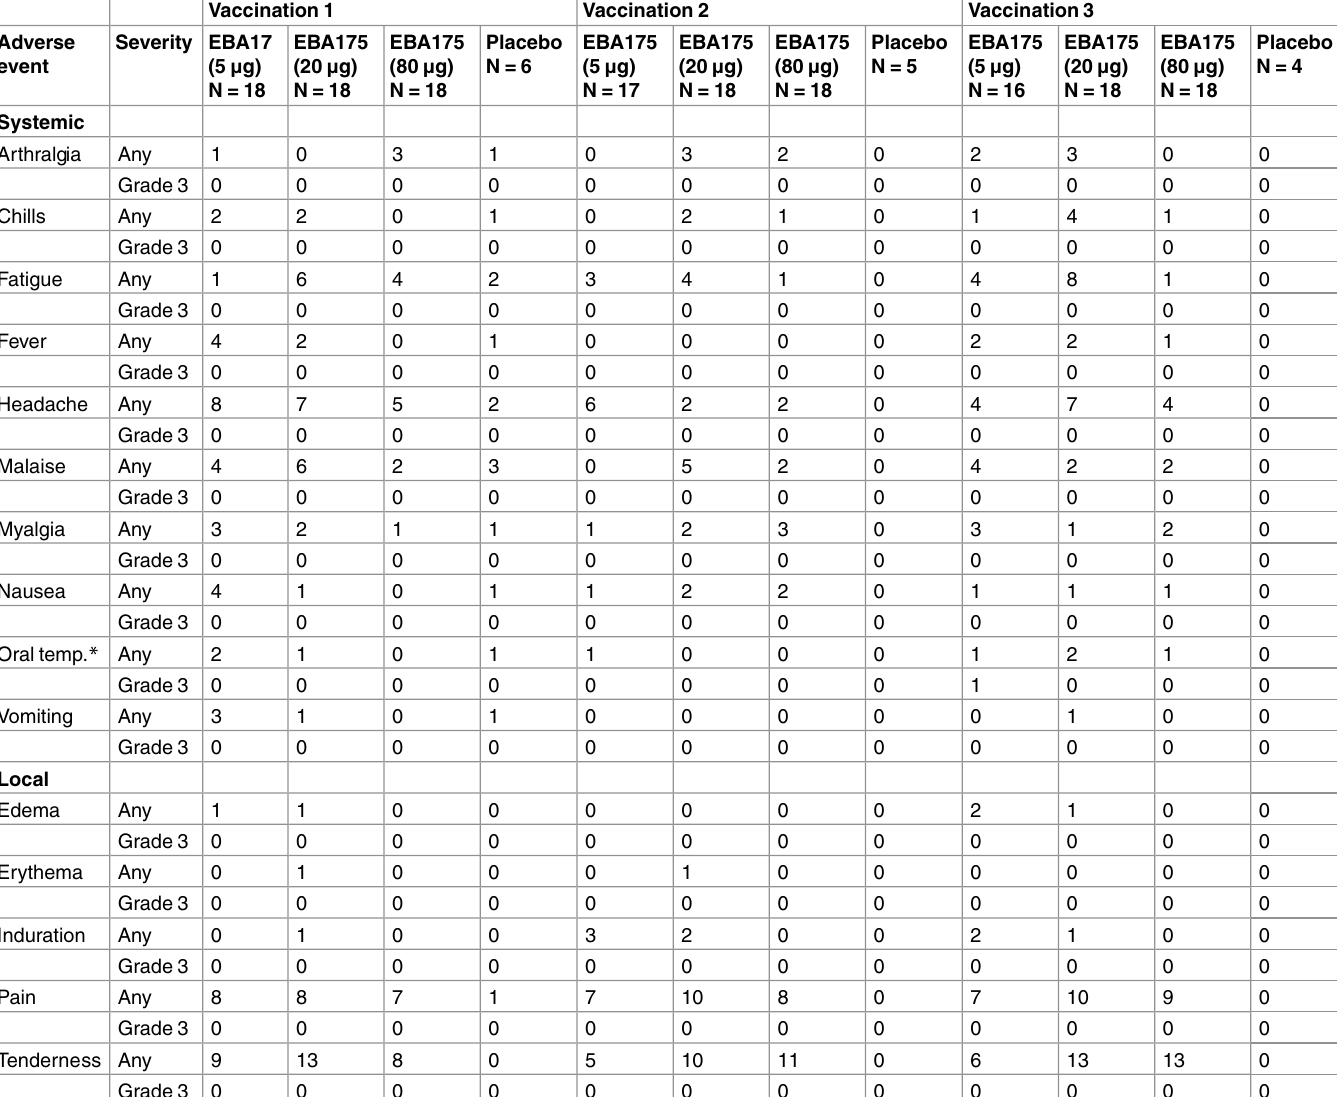
Table 2. Adverse events by severityvaccine dose and frequency of